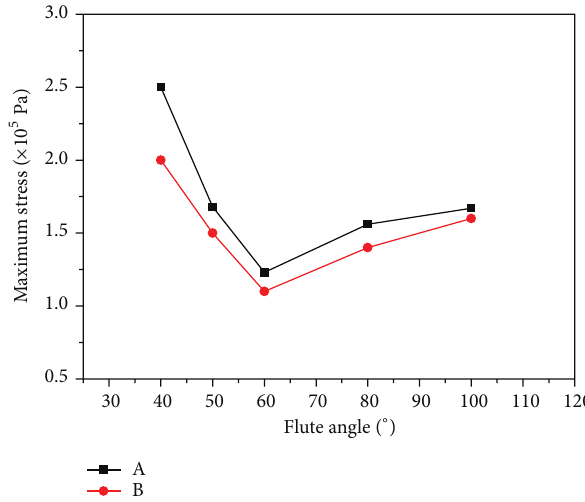
Figure 19: Maximum stress of A, B point in the models with different flute angle in the drop